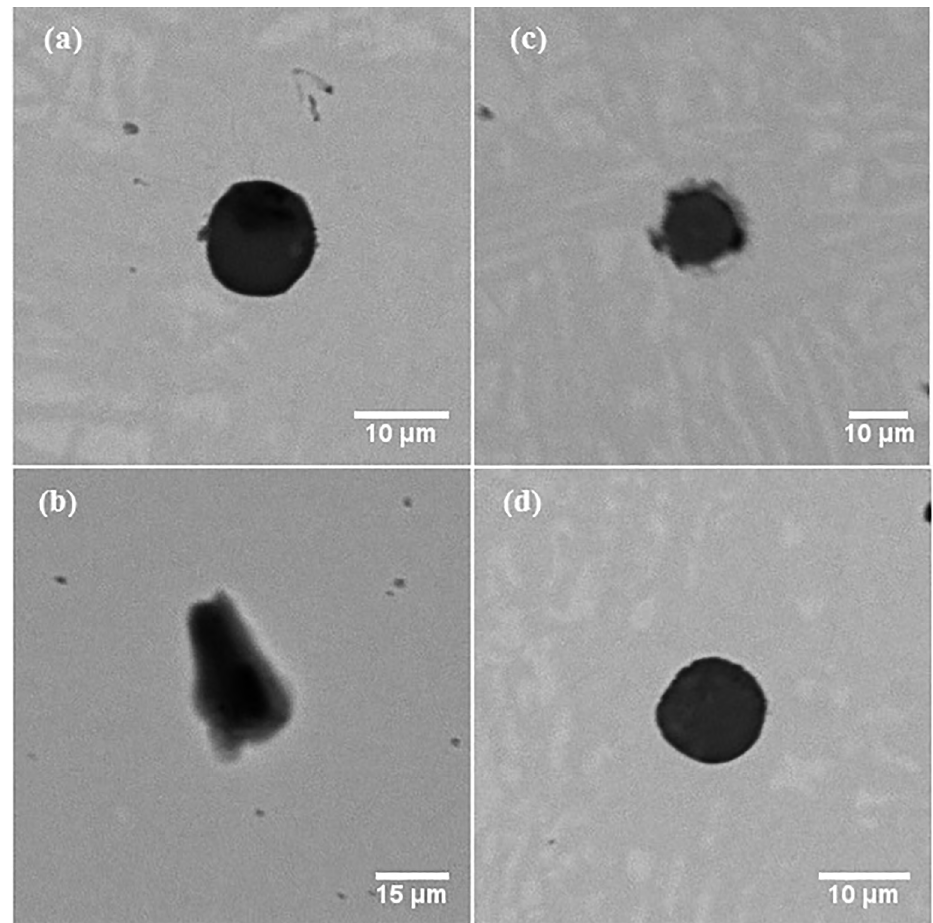
Figure 8. Morphology characterization of inclusions from (a,b) before and (c,d) after vacuum degassing.